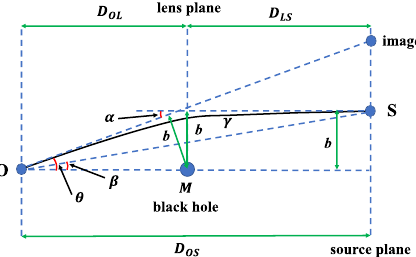
Fig. 4 The schematically plot of the weak gravitation lensing. The particles emitted from a distant source (labeled by S ) are lensed by a central black hole. In this figure, D OS is the distance between the observer (labeled by O ) and source plane, D OL is the distance between O and lens plane, D LS is the distance between lens plane and source plane. The central black hole is in the middle of lens plane. The angle β denotes the angular position of S with respect to the “optical axis” OM, and θ is the angular position of the lensed image of S detected by O . The α is the gravitational deflection angle of particles traveling